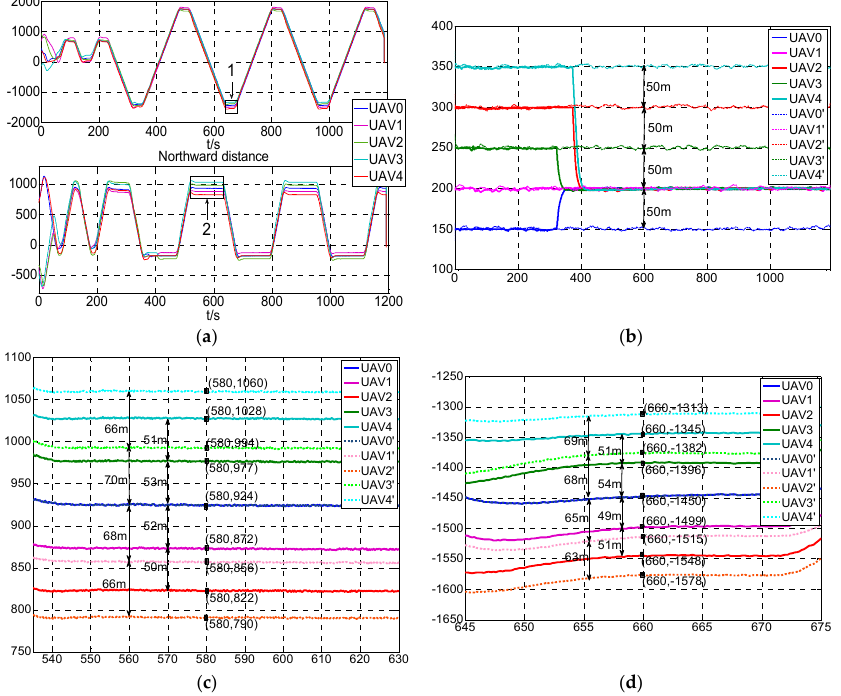
Figure 11. Experimental results of the wedge configuration. ( a ). The flight path of the five UAVs; ( b ). The height of five UAVs. The flight paths in full line belong to the UAV0 to UAV4 with USCC stochastic system model while the dotted line belong to the UAV0’ to UAV4’ are without the model; ( c ). Northward distances between the five UAVs which are indicated by “2” in ( a ). The flight paths in full line of UAV0 to UAV4 utilize the USCC stochastic system model while the dotted line of UAV0’ to UAV4’ do not use the model; ( d ). Eastward distances between the five UAVs which are indicated by “1” in ( a ). The flight paths in full line of UAV0 to UAV4 use USCC stochastic system model while the dotted line of UAV0’ to UAV4’ do not use the model.